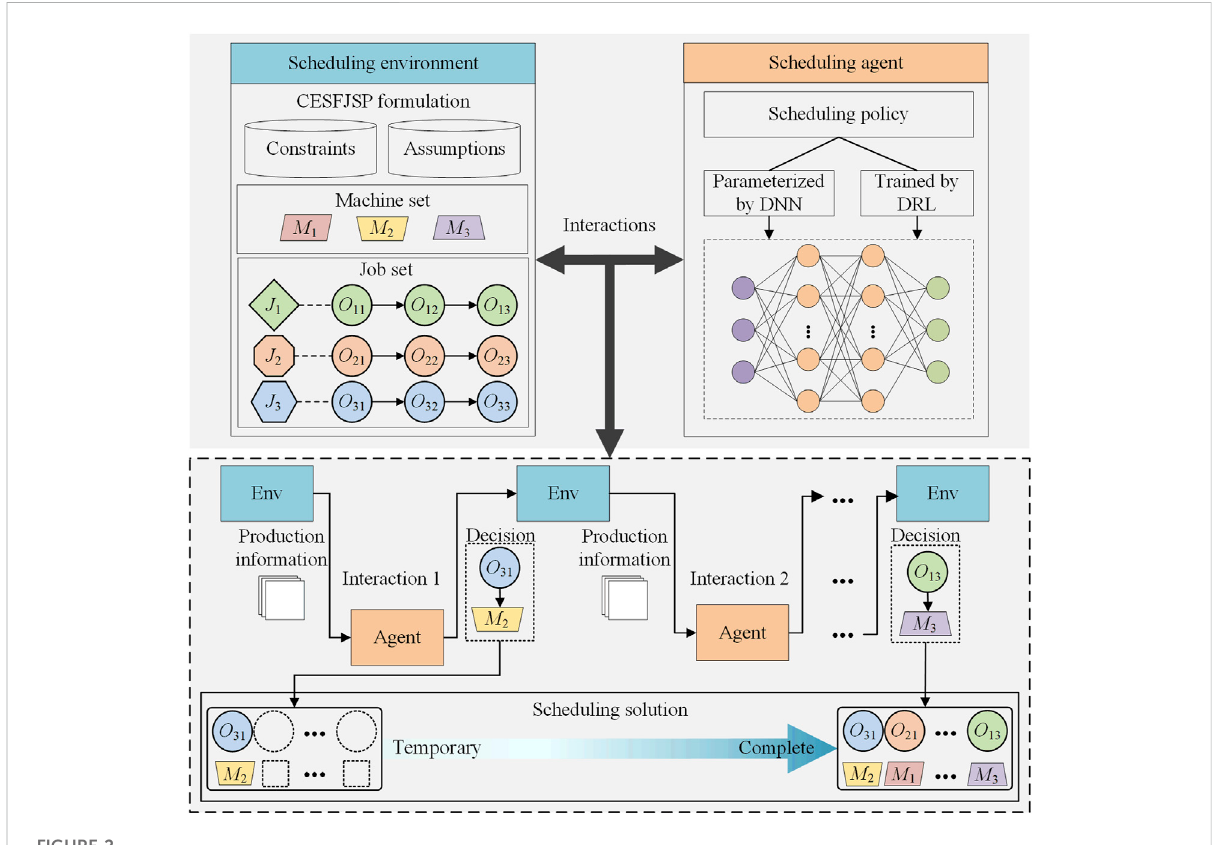
FIGURE 2 Framework of the DRL scheduling model for